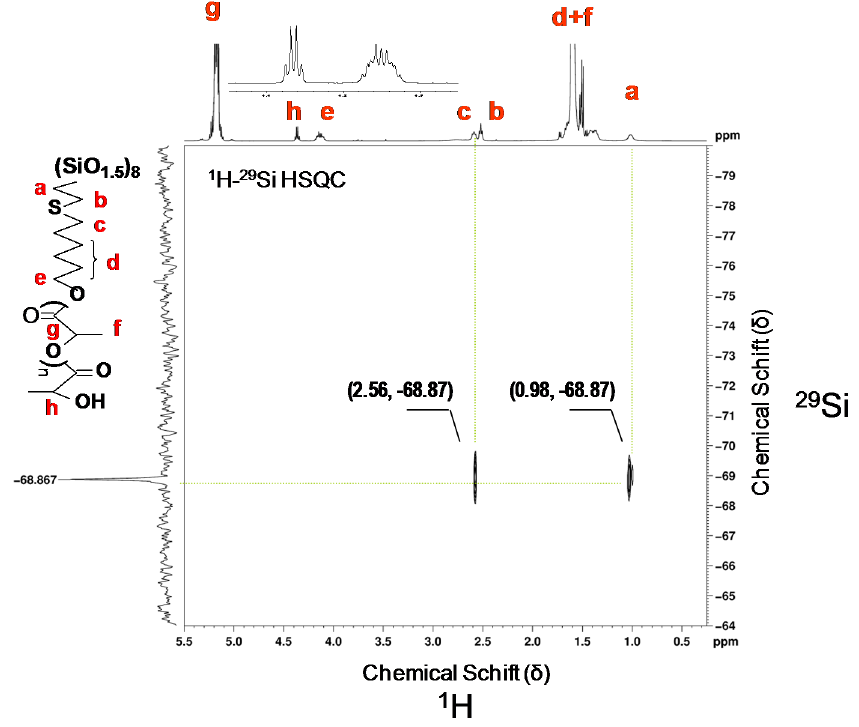
Figure 5. The 1 H– 29 Si HSQC NMR spectrum of star-shaped (POSS-S-PLA)(5) obtained by polymerization of L,L-dilactide from octakis-2[(6-(hydroxyhexyl)thio]ethyl-octasilsesquioxane (1) catalyzed by tin (II) 2-ethylhexanoate. Molecular weight of the hybrid M n = 28,500, PDI = 1.15 and M n of polylactide chain M n =